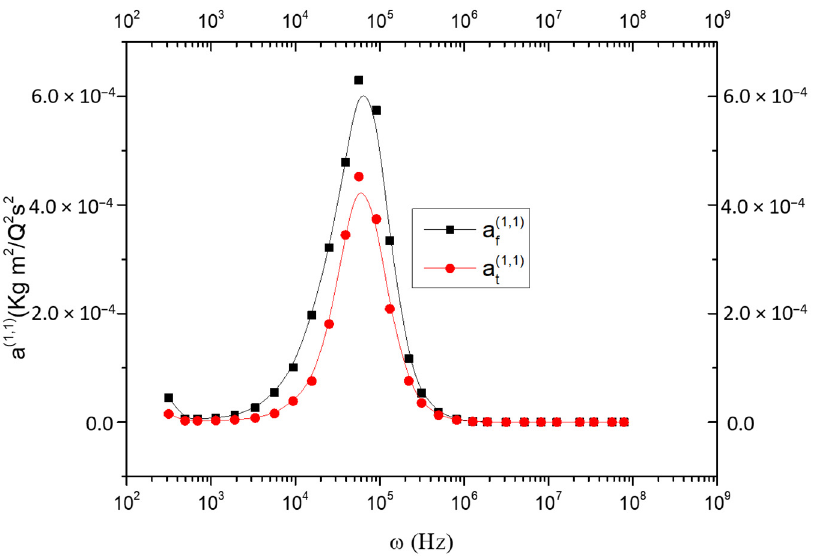
Figure 9. Comparison between normal (black line) and cancerous cells (red line) state coefficients a (1,1) as a function of frequency, see Equation (A16).